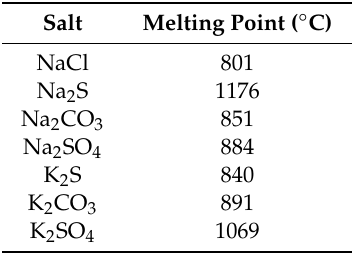
Table 1. Melting points of inorganic salts presented in black